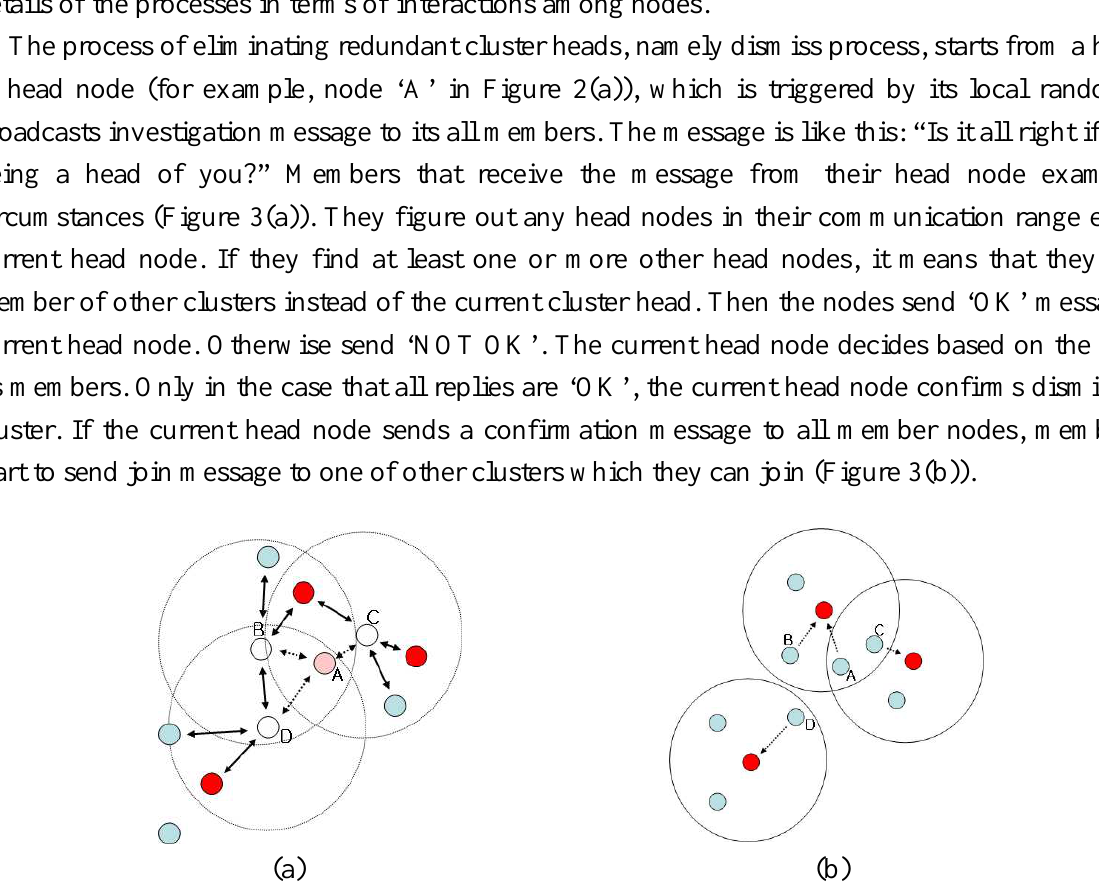
Figure 3. Example of ‘Dismiss’